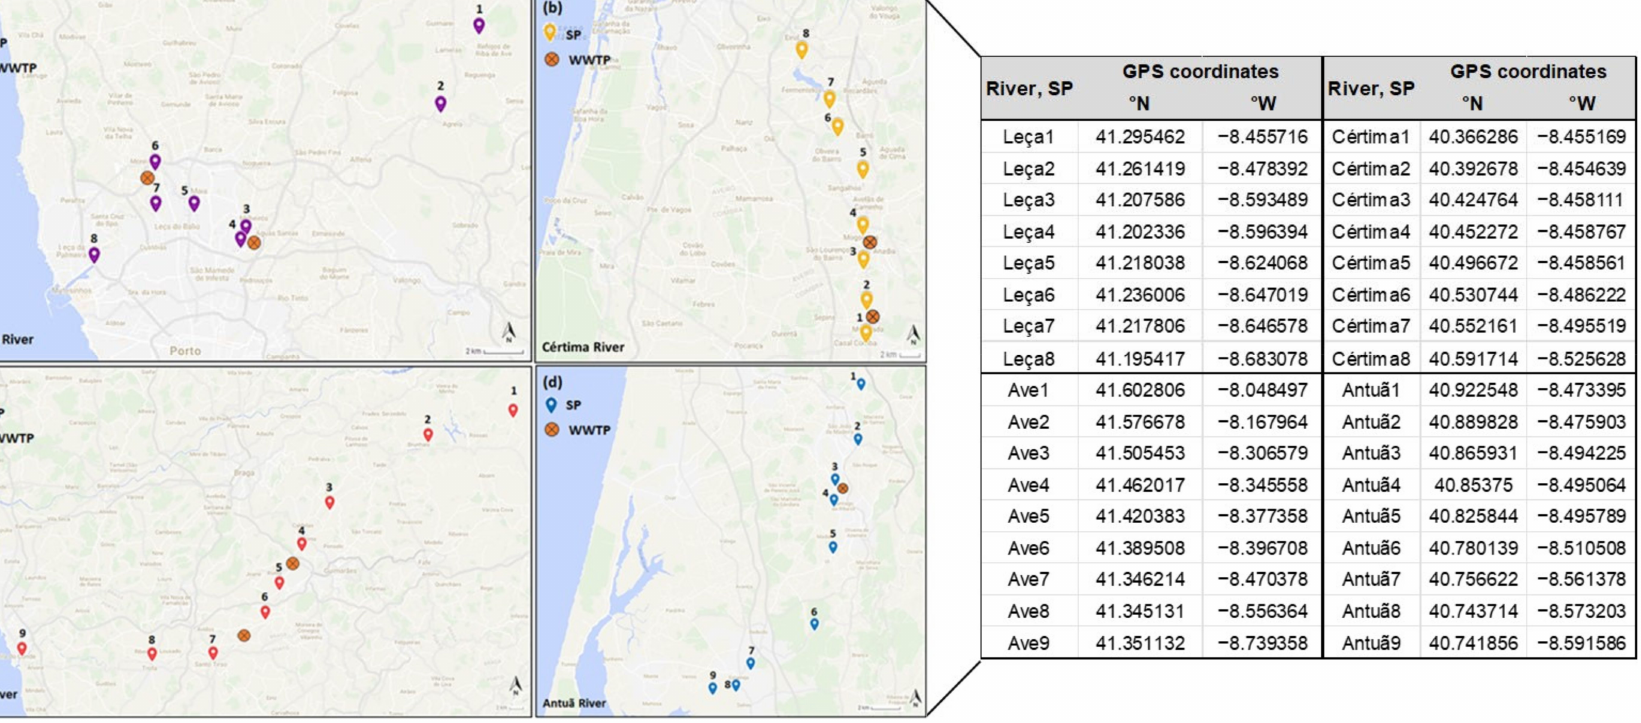
Figure 4. Location of each sampling point (SP) and WWTP in the target rivers: ( a ) Leça; ( b ) C é rtima; ( c ) Ave and ( d ) Antu ã ; and respective GPS